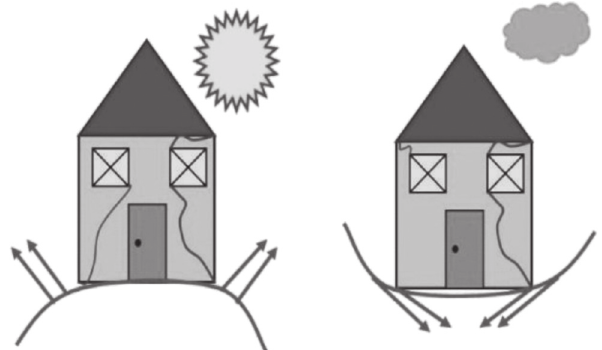
Figure 1: Swell and shrinkage in the perimeter of a structure during cyclic wet and dry conditions